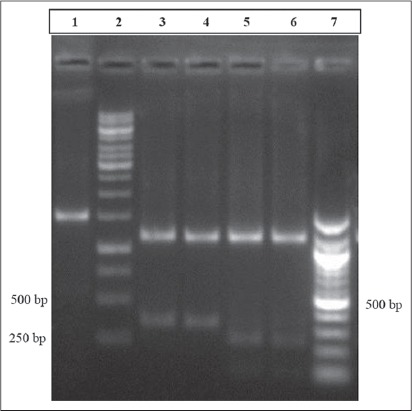
Gel electrophoresis of mitochondrial D-loop gene fragments of Indian wild and domestic pig sequences digested with BsrILane 1: Undigested productLane 2: 1 Kb DNA ladderLane 3,4: Digested PCR product of domestic pigLane 5,6: Digested PCR product of Indian wild pigLane 7: 100 bp DNA ladder.